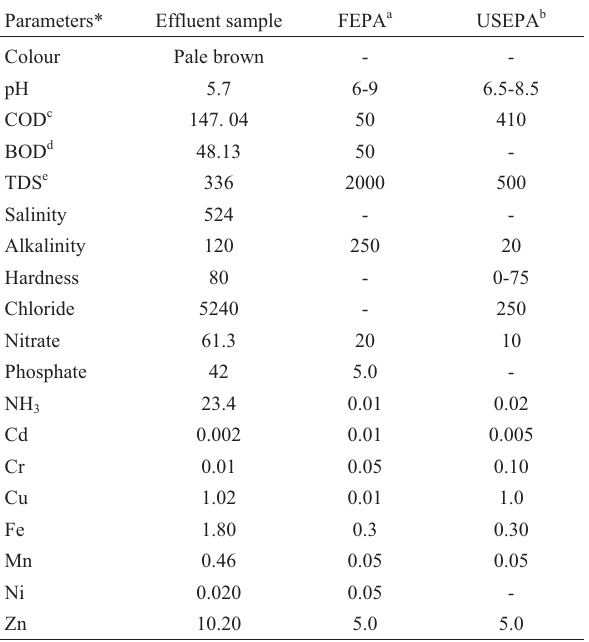
Table 1 - Physico-chemical characteristics of the pharmaceutical effluent assessed for